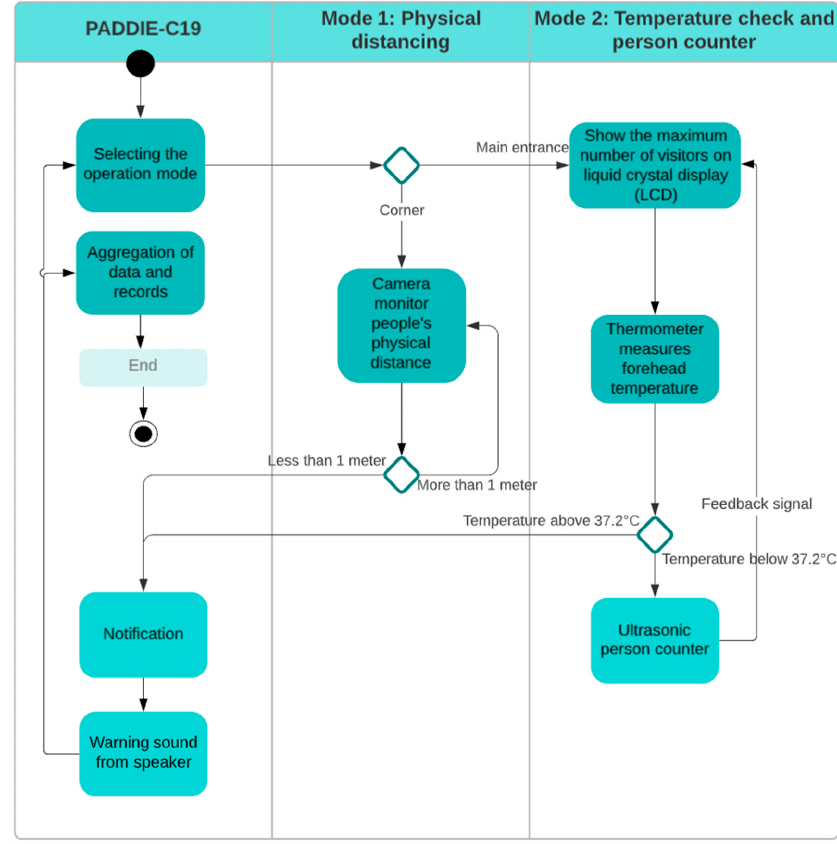
Figure 1. The proposed PADDIE-C19 system’s flow chart.